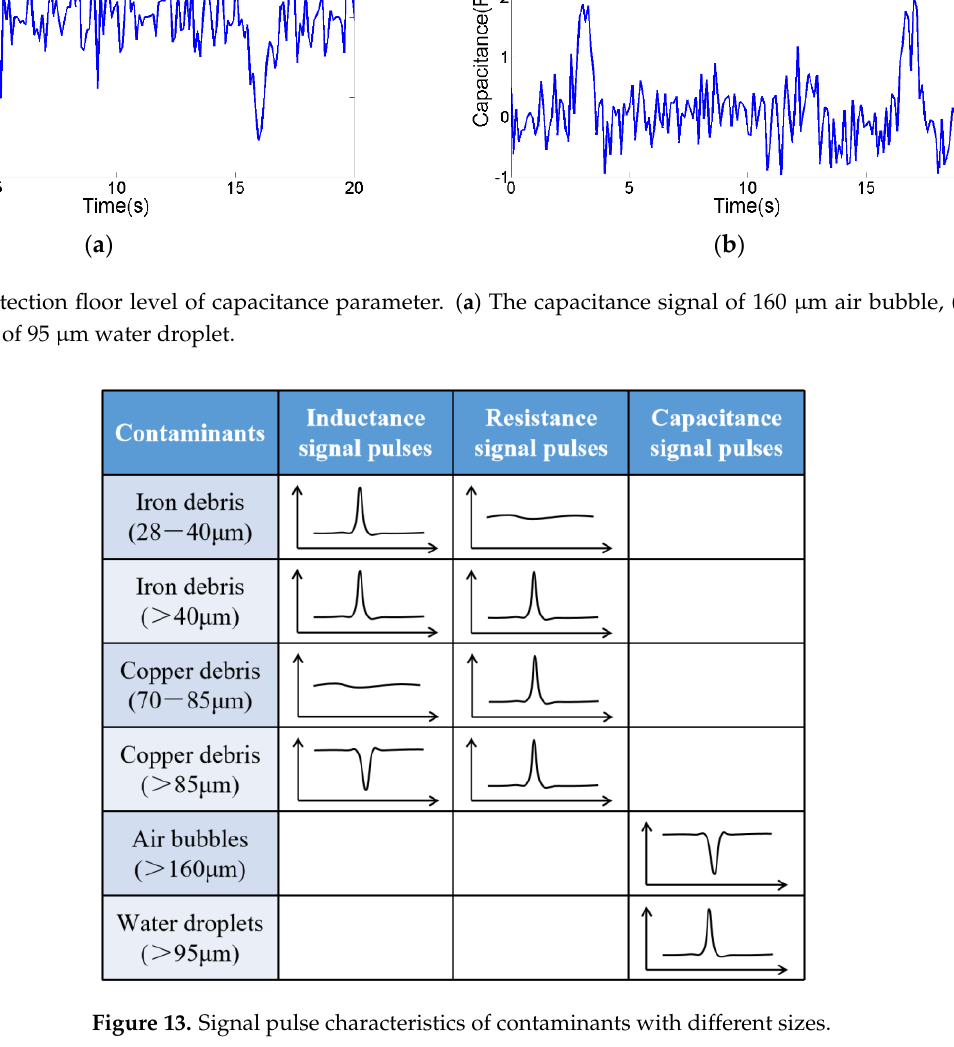
Figure 12. The detection floor level of capacitance parameter. ( a ) The capacitance signal of 160 μm air bubble, ( b ) the